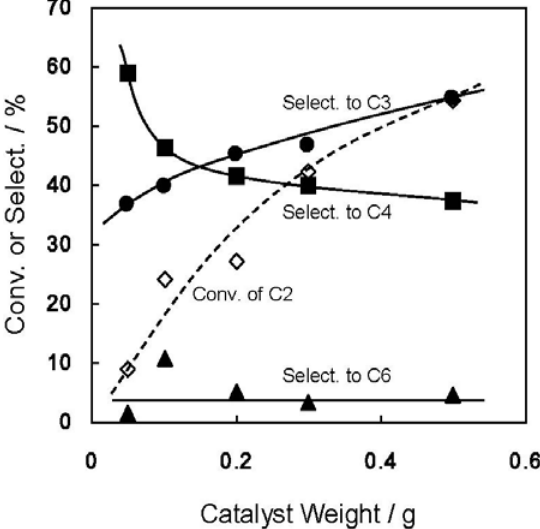
Figure 1. Change in ethene conversion and product distribution at 673 K with weight of Ni-M41(43). The codes C2–C6 mean ethene, propene, butenes, and